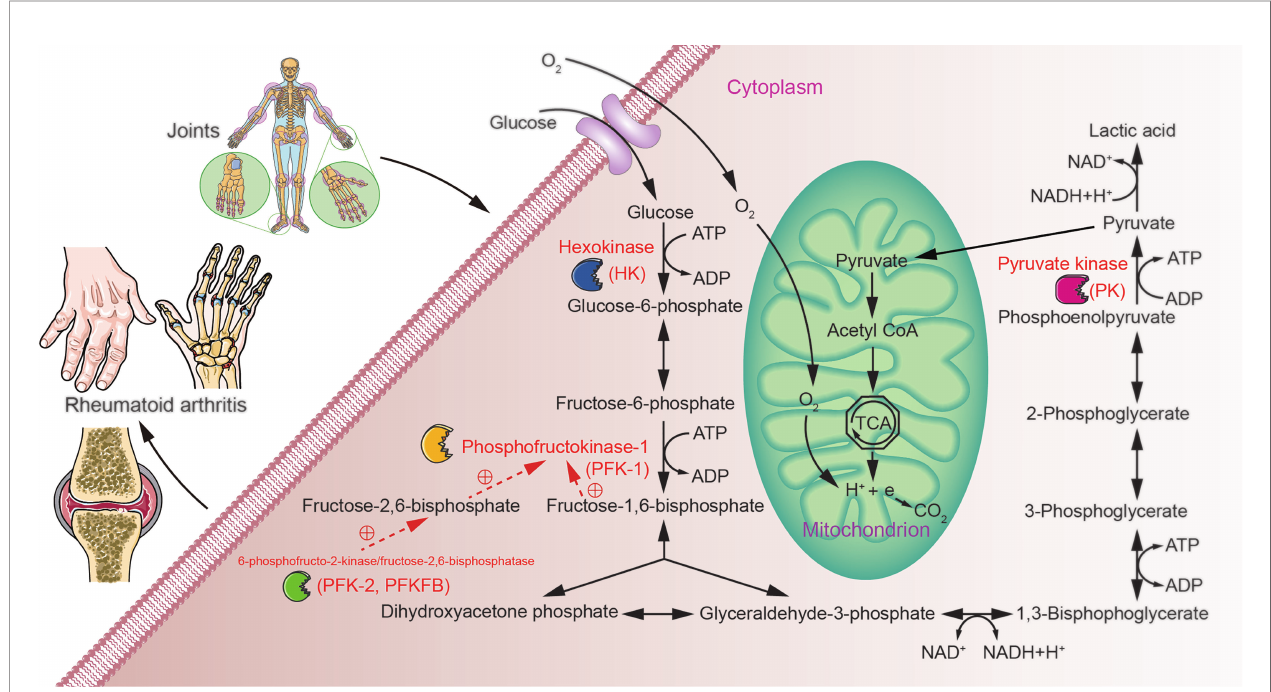
FIGURE 1 | Possible role of glucose metabolism during RA. Over- or under-expression of glycolysis rate-limiting enzymes may contribute to metabolic differences in the tissues of patients with RA through aberrant regulation of glycolytic